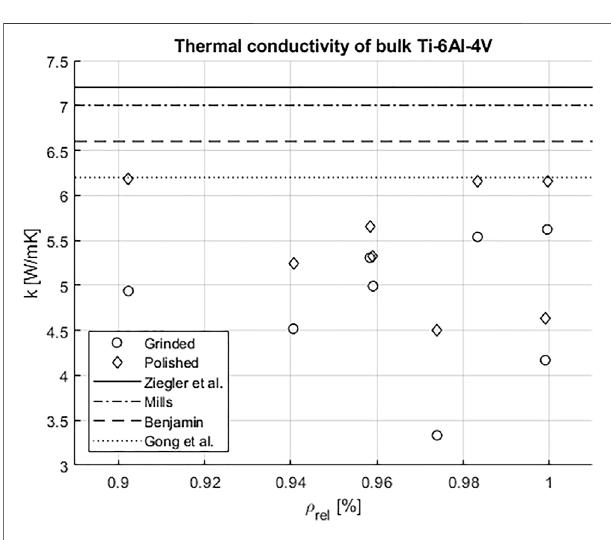
FIGURE 2 | Thermal conductivity against relative density of PBF-LB/M